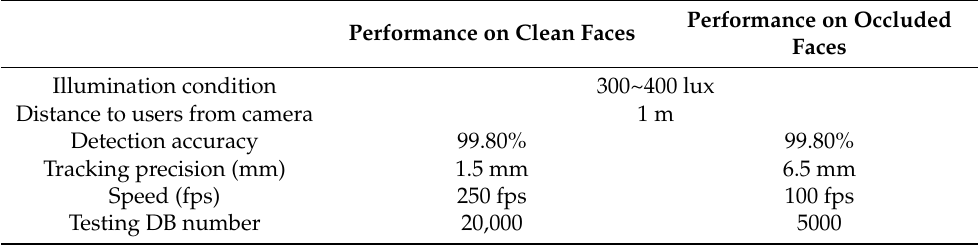
Figure 11. Illustration of the proposed eye tracking method with pupil segmentation modules. The green circles around the red points on the eyes indicate the pupil segmentation modules, which increase the accuracy of the eye tracking. The left side shows the left camera image from a stereo webcam, while the right side shows the image captured by the right camera. The left and right images were combined to calculate the 3D eye position via stereo image matching based on triangular interpolation. Table 3. Evaluation results of the proposed eye tracking algorithm.